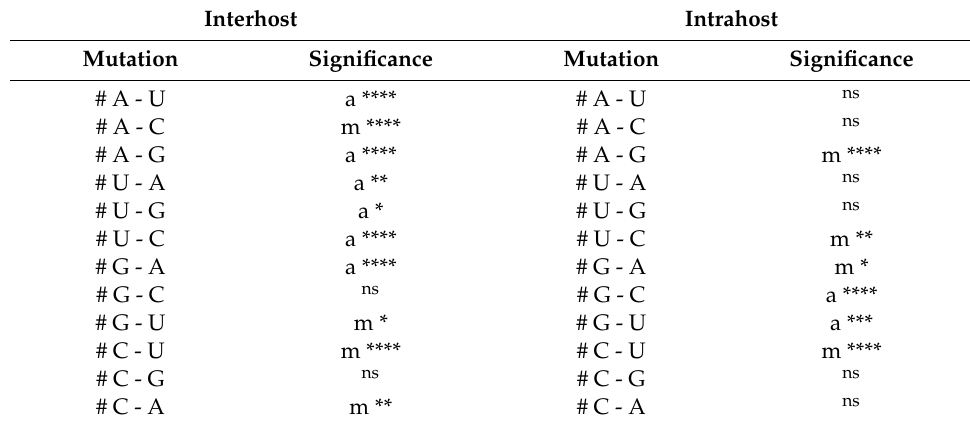
Table 3. Host bias of individual nucleotide